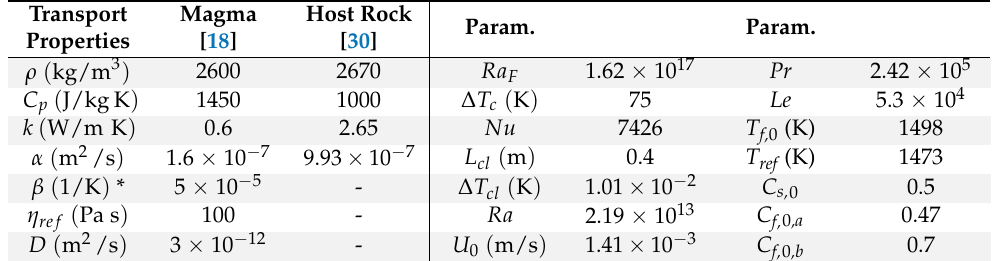
Table 1. Magma and host rock properties and parameters used in the mathematical